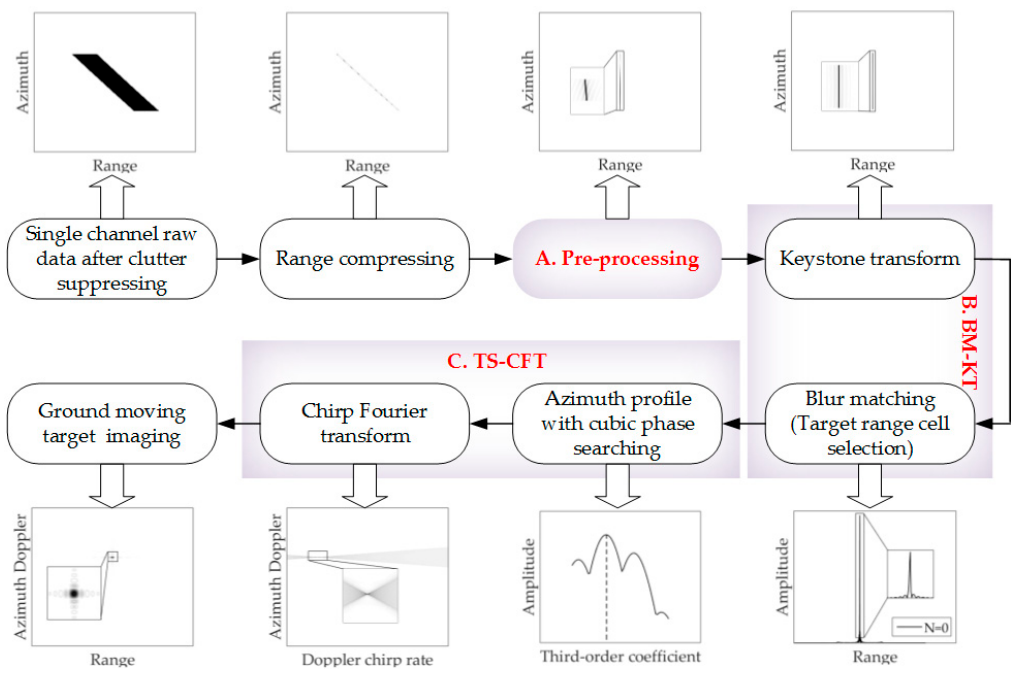
Figure 6. Flowchart of the proposed algorithm and corresponding subsections and theoretical results for a moving target.